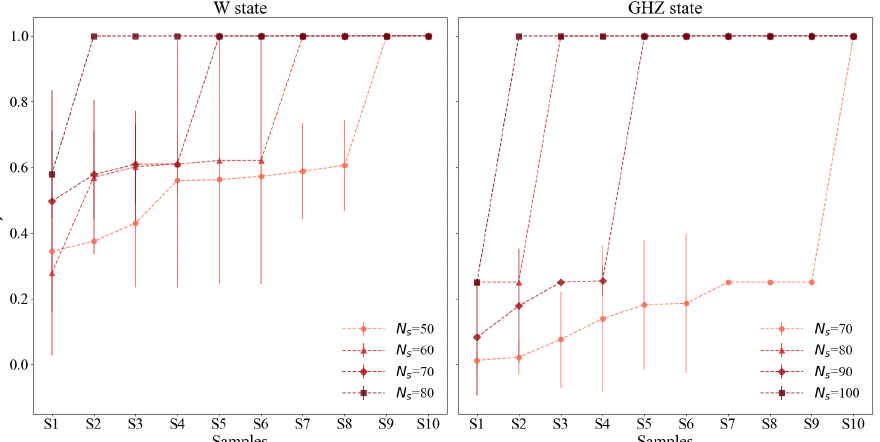
Figure 3. Average quantum fidelity between the reconstructed quantum state and the target quantum state for 100 random initialization. The x-axis corresponds to 10 independently generated train datasets. The dashed lines with a circle, triangle, diamond, and square represent the average values over the 100 random initialization corresponding to N s = 50, 60, 70, and 80, respectively. The error bars represent the standard derivations around the mean value.